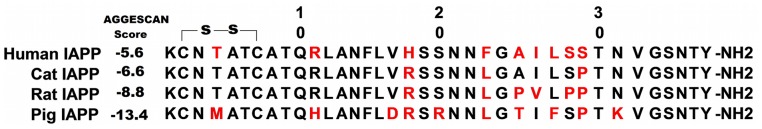
The four IAPP variants listed with aggregation propensities (Na4vSS values from AGGRESCAN server).The residues that differ from those of hIAPP are mainly located between residues 4–31 (see residues in red in the sequences). While human and cat IAPP has strong aggregation tendency contributing to T2D, rat and pig IAPP doesn't aggregate under normal conditions and is not toxic to β-cells.